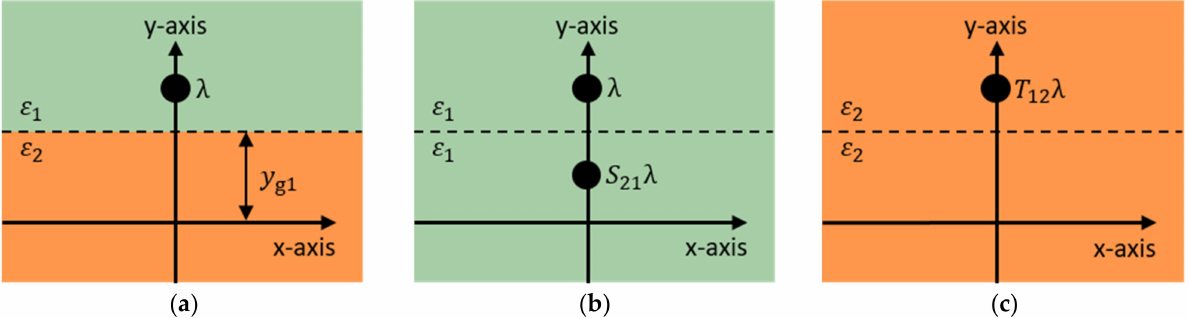
Figure 4. Application of the method of image charges at a dielectric boundary: ( a ) Line charge above a dielectric half-space; ( b ) Solution for the upper space y ≥ y g1 ; ( c ) Solution for the lower space y ≤ y g1